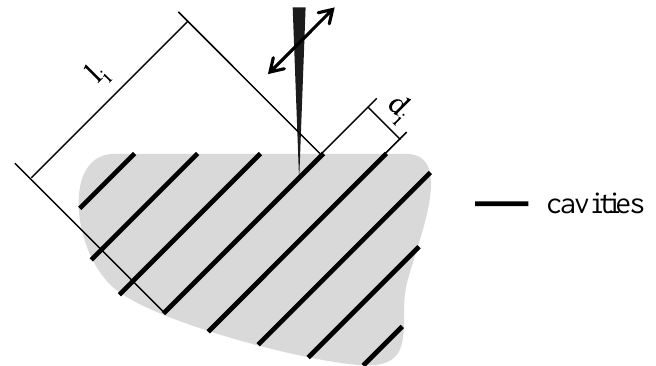
Figure 8. Arbitrarily shaped surface with dimensions of the individual cavities.